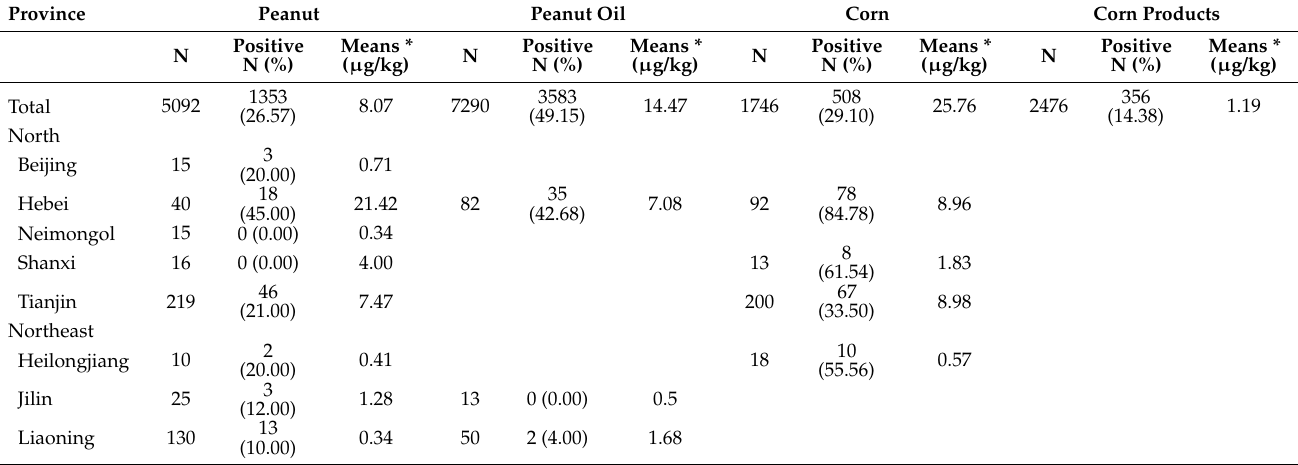
Table 1. AFT concentration in peanuts, peanut oil, corn, and corn products in different areas of China from 2010 to